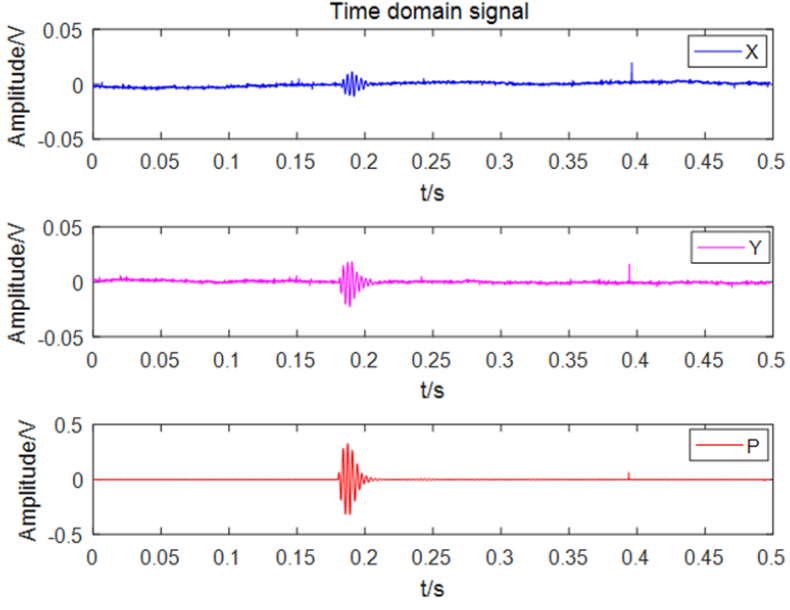
Figure 15. Time domain diagram of pulse signal.